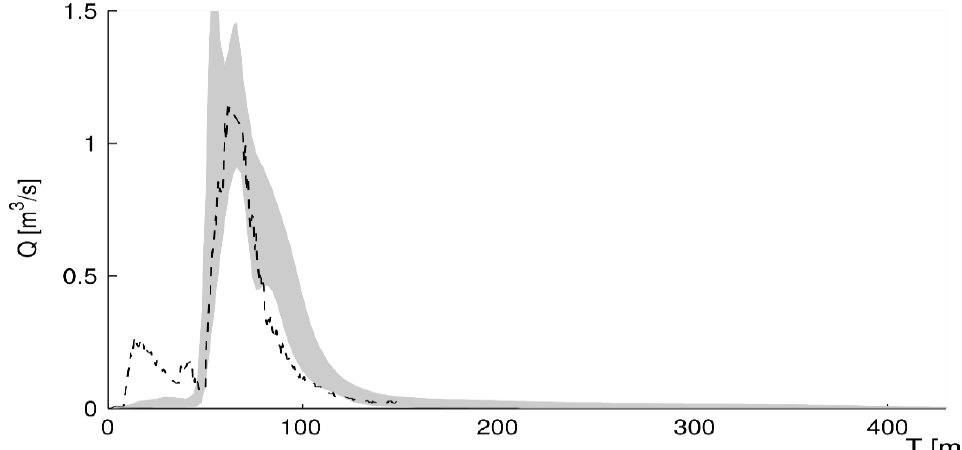
Figure 4. Exemplary results of calculations and measurements for the confidence interval of 95% using the Generalized Likelihood Uncertainty Estimation (GLUE) method for the hydrograph of outflow from the catchment (30 July 2010).